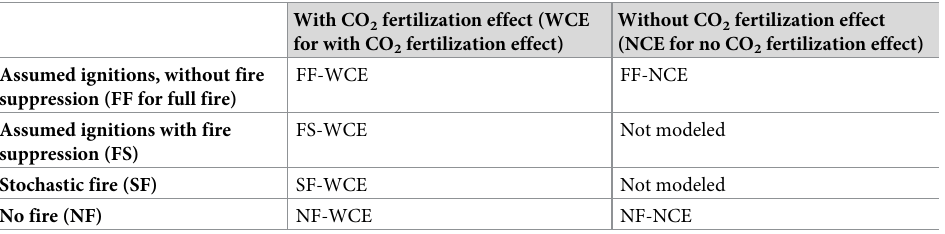
Table 1. Fire and CO 2 fertilization scenarios used for this study’s MC2